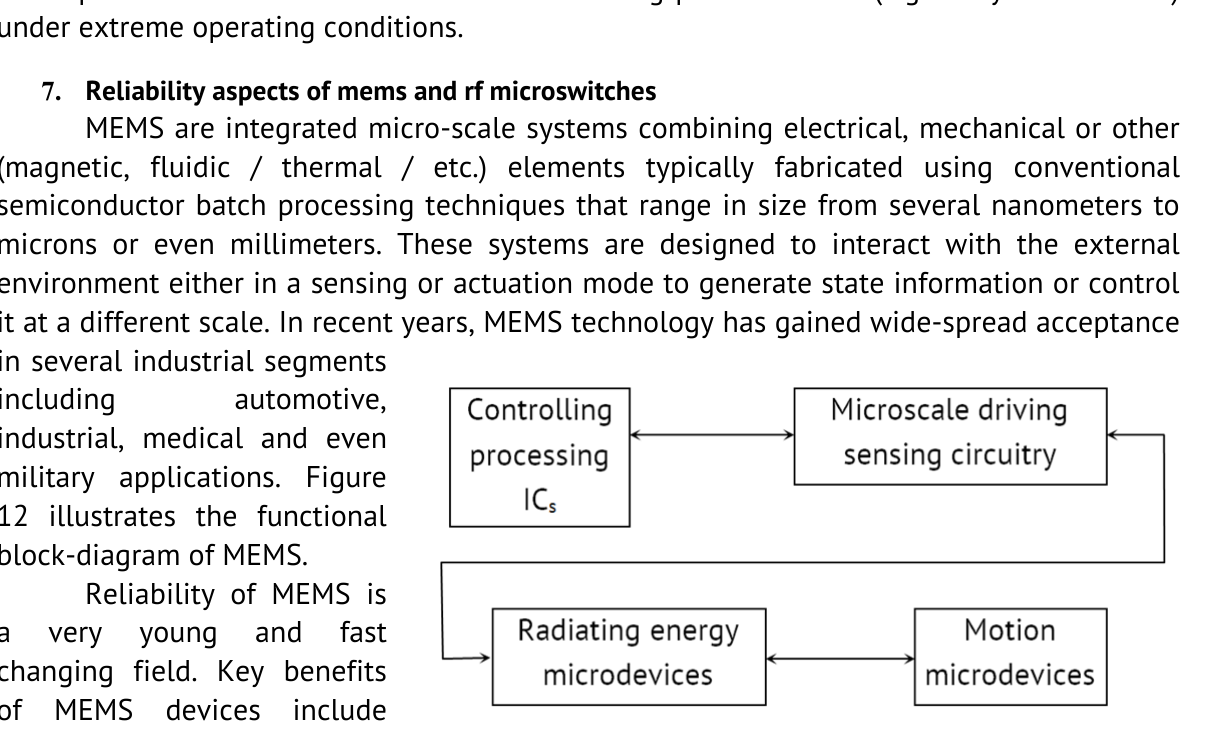
Figure 12. Functional block-diagram of